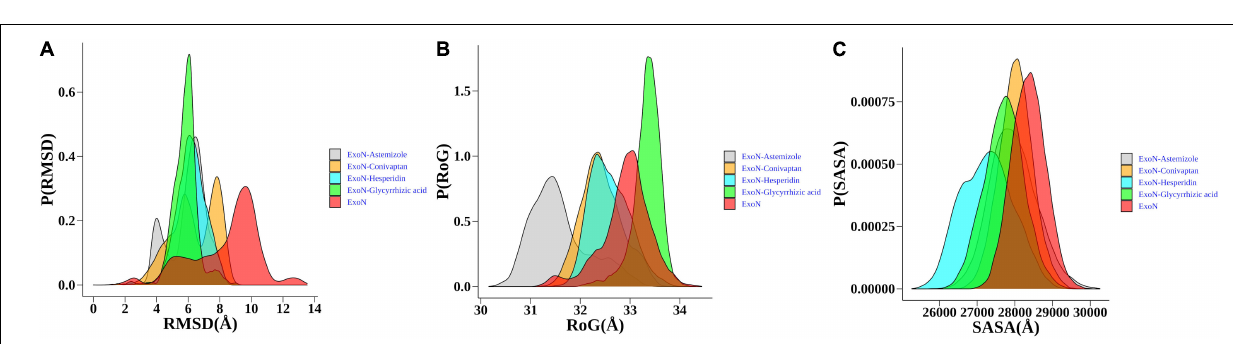
FIGURE 5 | Probability distribution plots of structural order parameters. (A) C α -backbone RMSD, (B) RoG, (C) SASA of ExoN, the docked complexes, ExoN–astemizole and ExoN–conivaptan, ExoN–hesperidin, and ExoN–glycyrrhizic